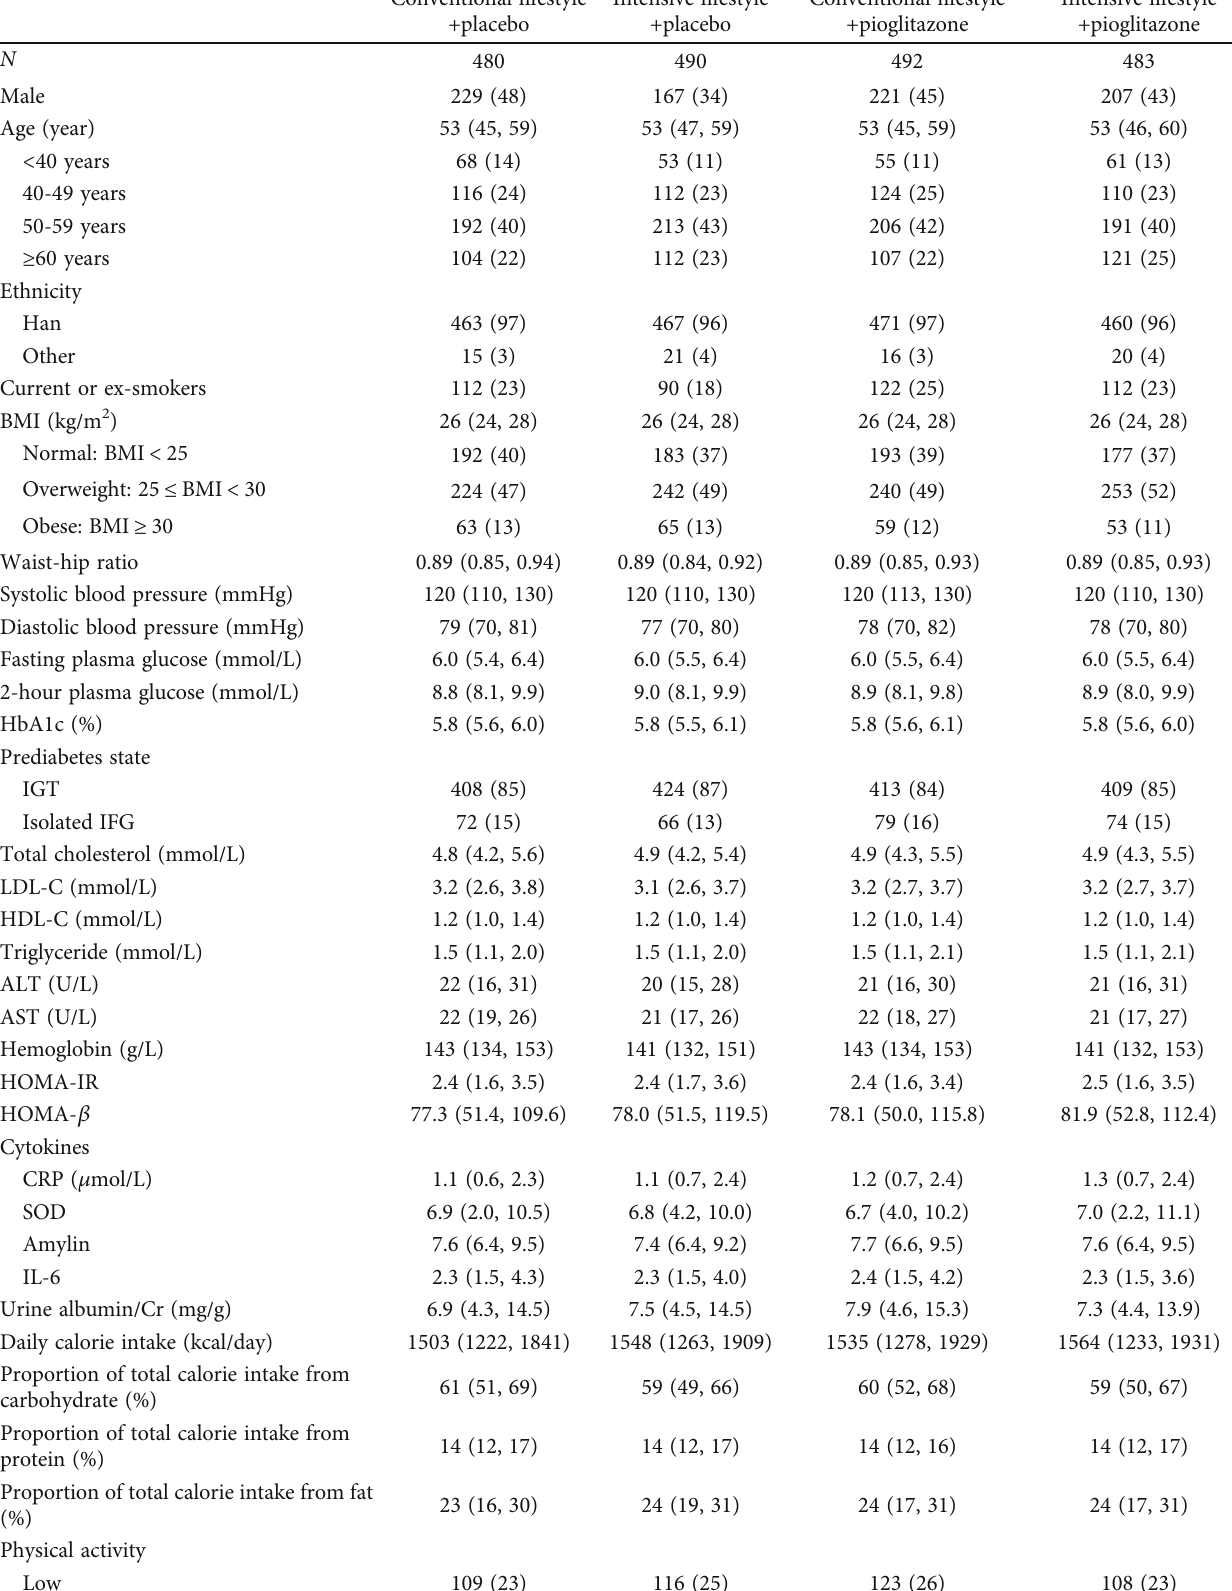
Table 1: Baseline characteristics of the participants by study